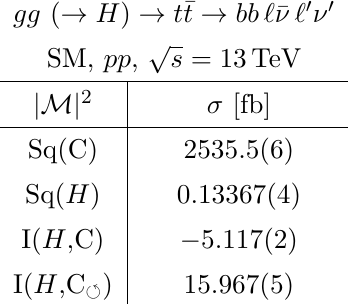
Table 11 . Standard Model. Other details as in table